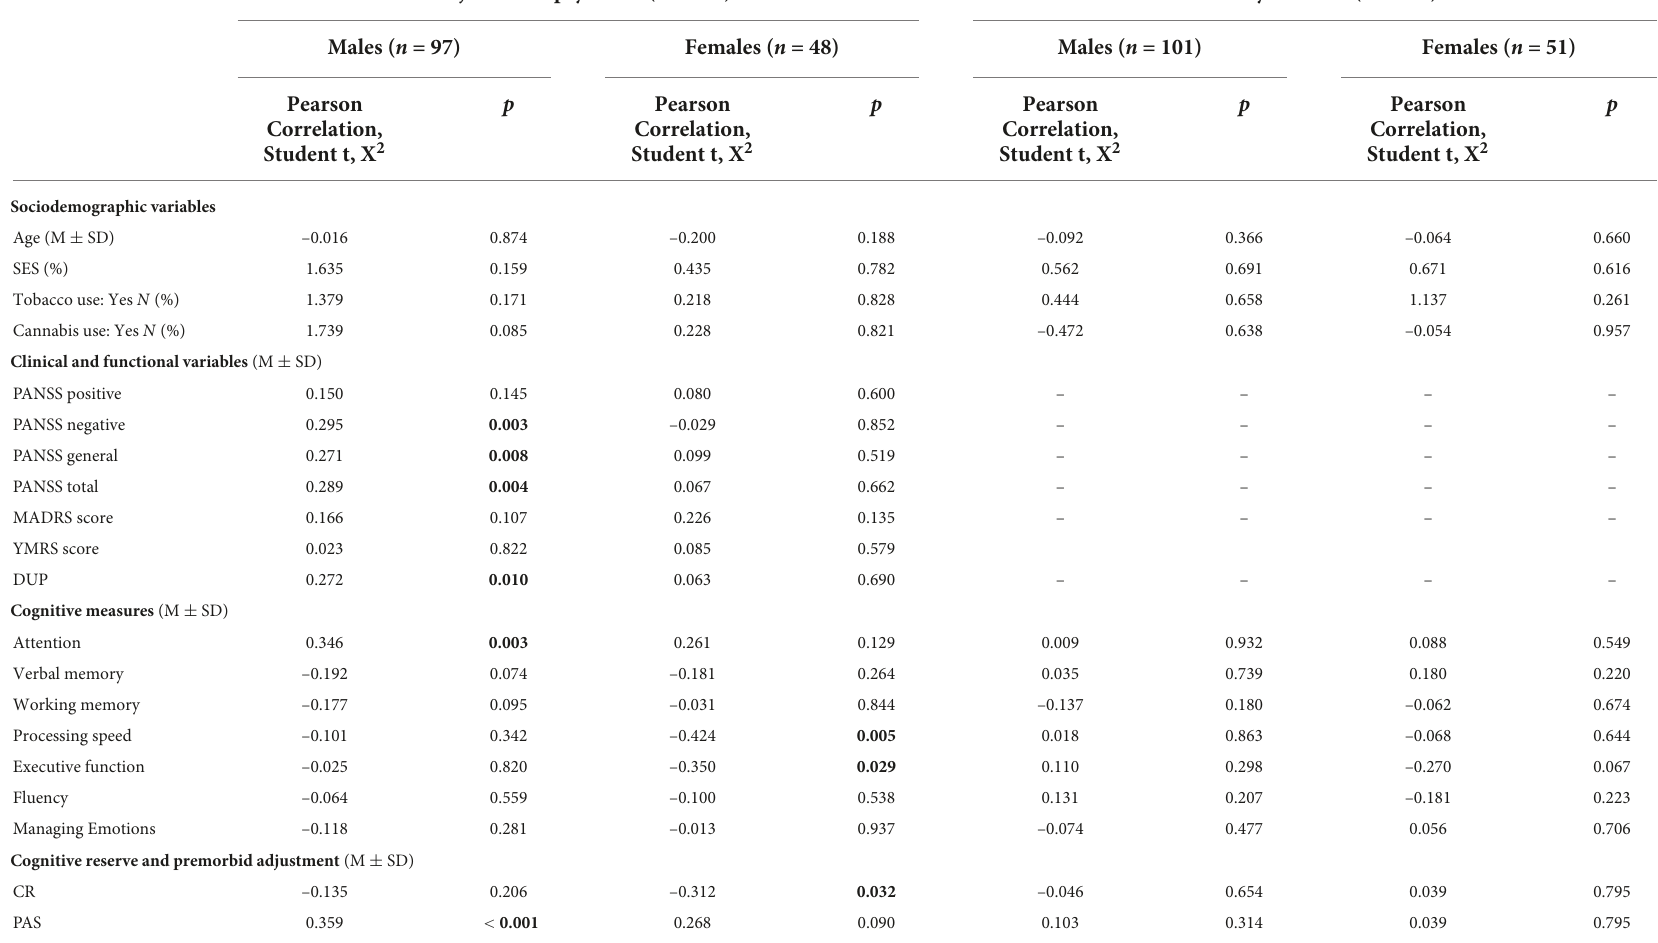
TABLE 3 Correlations between psychosocial functioning (FAST) at follow-up and socio-demographic and clinical variables at baseline in subjects with psychosis and healthy controls. Subjects with psychosis ( n = 145) Healthy controls ( n = 152) Males ( n =